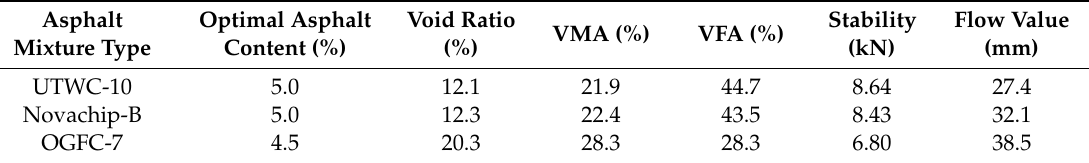
Table 5. The volume parameters of thea three asphalt mixtures.